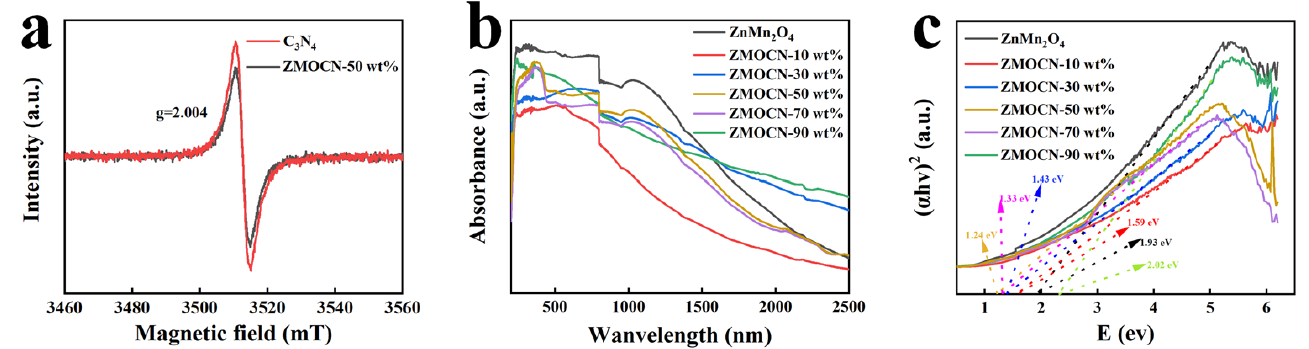
Figure 3. EPR spectra ( a ) of C 3 N 4 and ZMOCN-50 wt%. ( b ) UV–Vis DRS of ZMOCNs. ( c ) The corresponding ( α h ν ) 2 versus h ν curves of